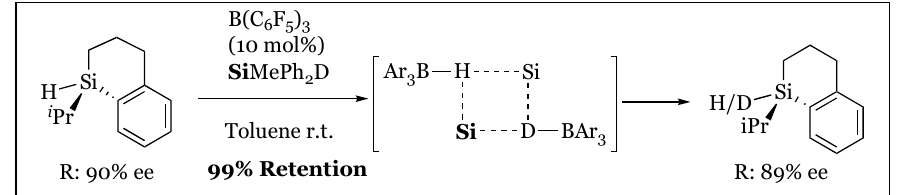
Figure 37. Isotopic H/D scrambling in the presence of tris(pentafluorophenyl)borane with silane retention via four-membered transition state.